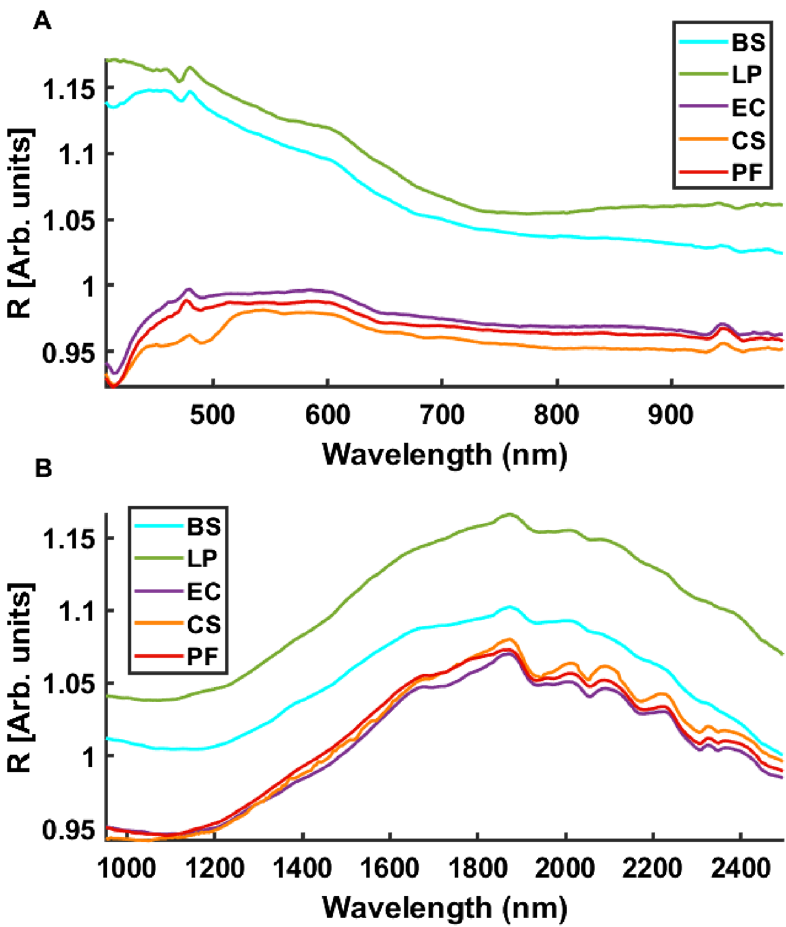
Figure 2. Mean VNIR ( A ) and SWIR ( B ) spectra of all bacterial species collected from stainless steel. R = Reflectance. Arb.units = Arbitrary units. BS: Bacillus subtilis ; LP: Lactobacillus plantarum ; EC: Escherichia coli , CS: Cronobacter sakazakii ; PF: Pseudomonas